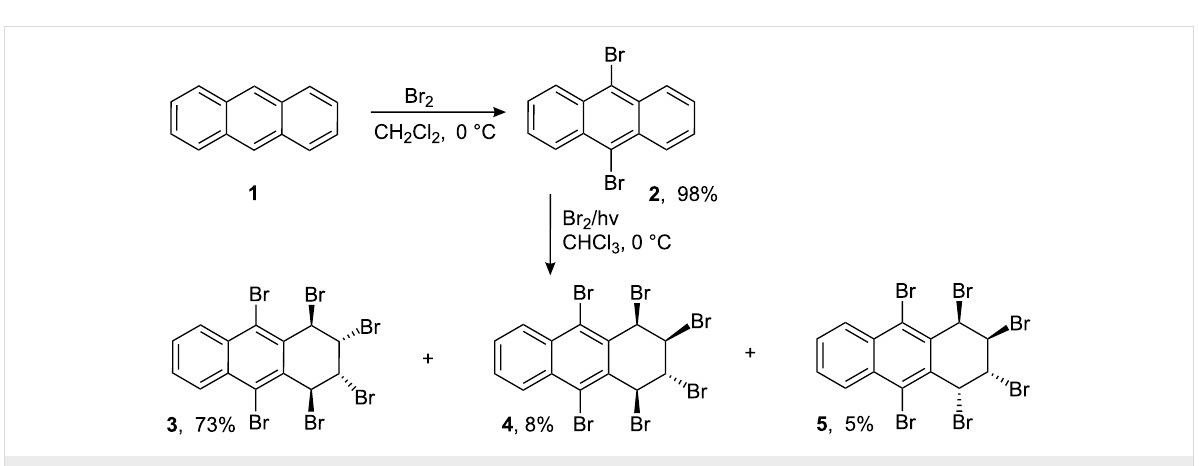
Scheme 1: Photobromination of